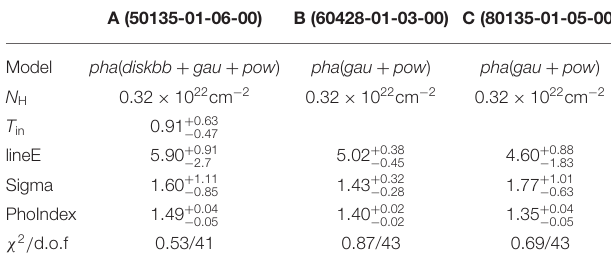
FIGURE 3 | The relation between photon index, Ŵ and unabsorbed 2–10 keV X-ray flux, where the filled and open points represent the observations in the rise phase and in the decay phase, respectively. TABLE 1 | The best-fit parameters for A, B, and C point in Figure 1